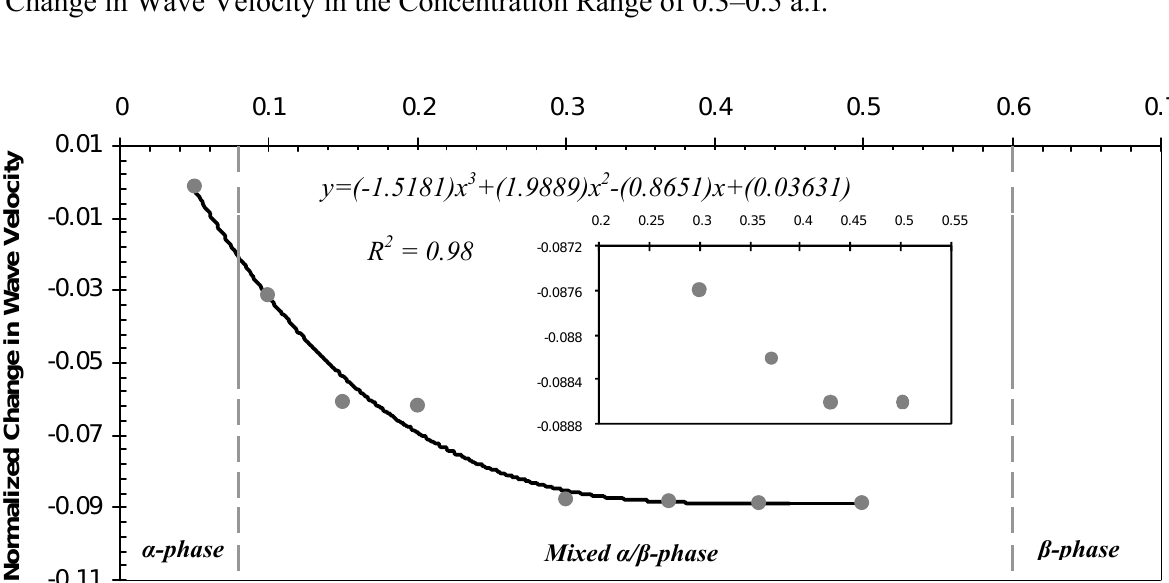
Figure 9. Normalized Change in Phase Velocity at Different Levels of Hydrogen Concentrations. R 2 for Cubic Polynomial fit is 0.9848. Inset illustrates the Normalized Change in Wave Velocity in the Concentration Range of 0.3–0.5